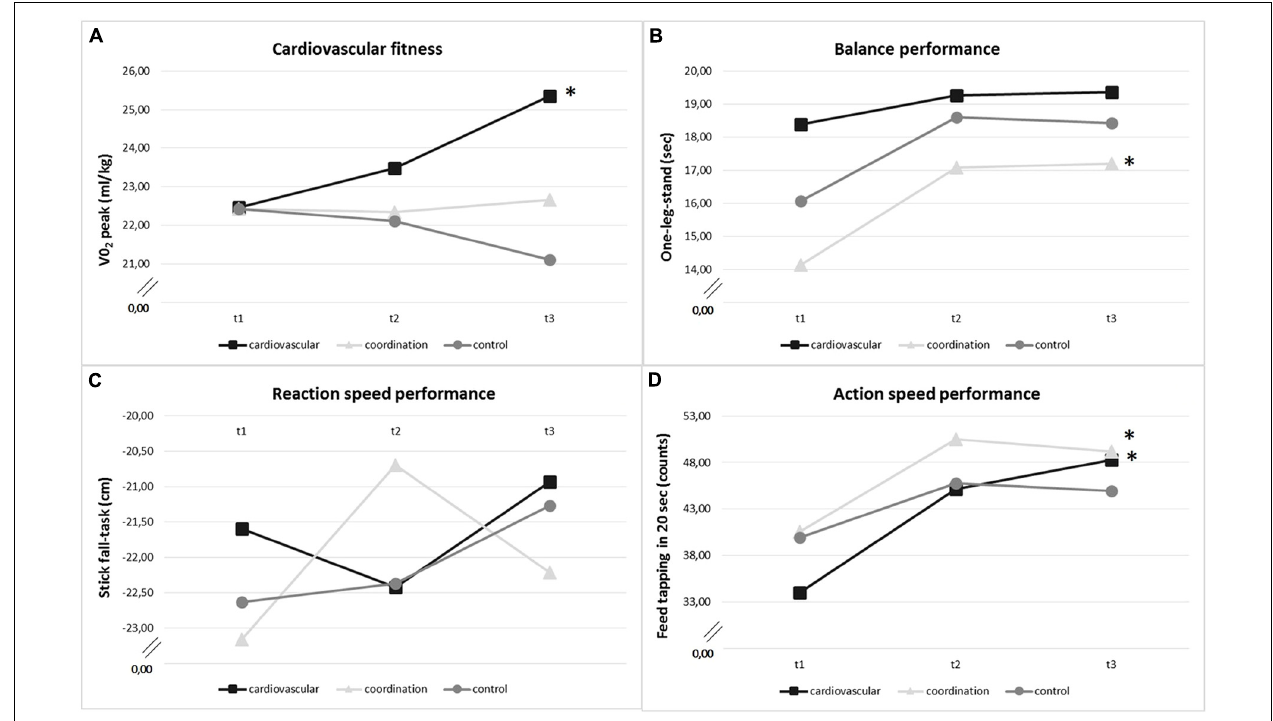
FIGURE 3 | Change of (A) cardiovascular fitness (VO 2 peak in ml/kg), (B) balance performance (one-leg-stand in seconds, max 20sec.), (C) reaction speed performance (stick-fall-task in cm), and (D) action speed performance (feet tapping in